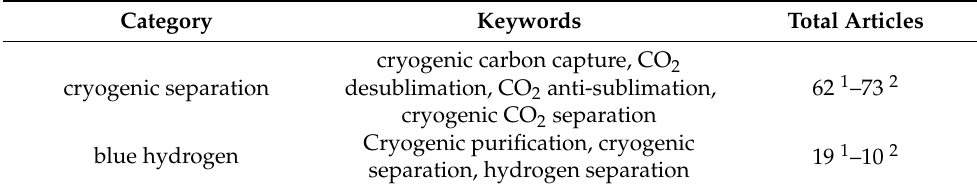
Figure 3. Cryogenic carbon capture technologies. Adaptation from [7]. 2.1. Conventional V-L Separation Cryogenic distillation is a well-established technology that achieves separation based on the different boiling points of CO 2 and the gas components in the mixture. This method has been used for natural gas purification, where the CO 2 is removed in the liquid phase. However, it is an energy-intensive method due to the high pressure employed and the requirement that solid formation be avoided to protect equipment and prevent clogging. To avoid CO 2 solidification, extractive distillation, or “Ryan Holmes” technology, makes use of heavier hydrocarbons (e.g., ethane), which increases the solubility of CO 2 in the liquid phase, operating temperature, and relative volatility, facilitating separation [10]. Gas-to-liquid carbon dioxide separation is well recognized as the advanced technol- ogy for the purification and compression of CO 2 captured in oxy-combustion. A CO 2 -rich flue gas derived from oxy-combustion is ideal for integration with a carbon dioxide puri- fication unit (CPU) for low temperature CO 2 separation. Previous work has evaluated CO 2 removal in a two-stage compression at approximately 15 and 30 bar and by the partial